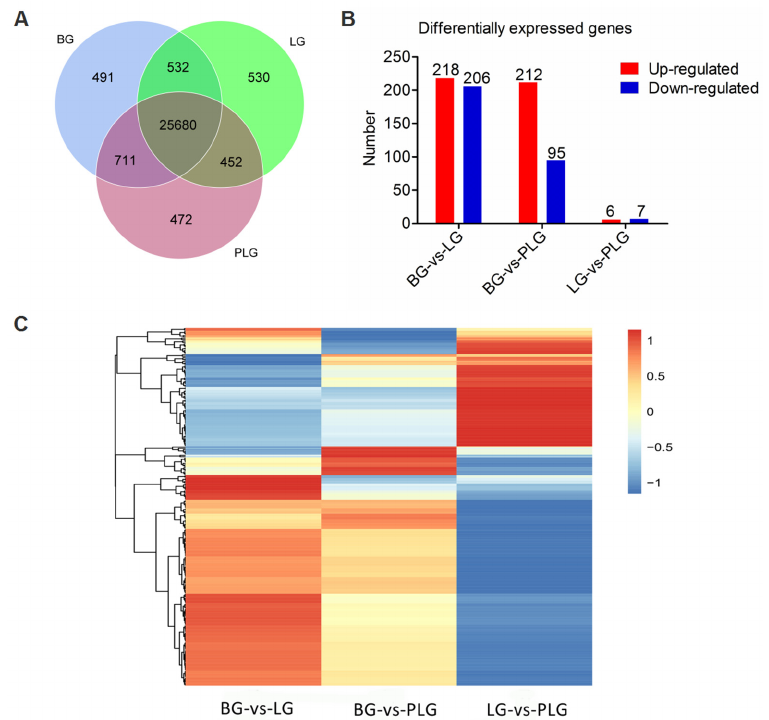
Figure 4. Hippocampal transcriptome. ( A ) Venn diagram for the BG, the LG, and the PLG. ( B ) Differently expressed genes (DEGs) among treatment groups (fold change ≥ 2, adjusted p -value < 0.05). ( C ) Heat map of DEGs. BG, barren environment group; LG, environment enriched with a litter materials group; PLG, environment enriched with perches and a litter materials group.